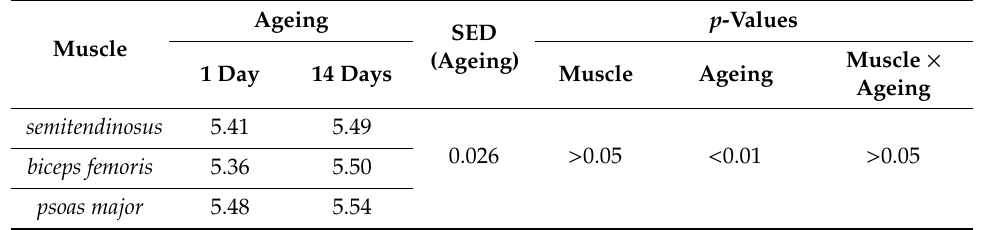
Table 1. E ff ect of muscle ( semitendinosus ; biceps femoris ; psoas major ) and ageing (1 day post mortem vs. 14 days post mortem) on pH of beef. Values are predicted means.